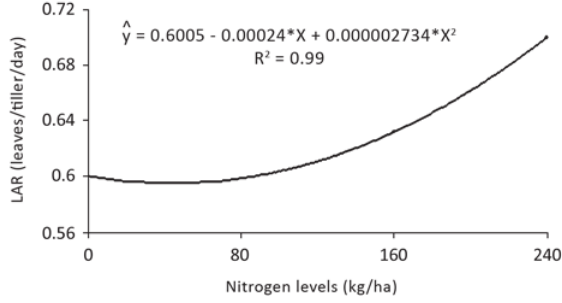
Figure 1 - Rate of the leaf appearance rate (LAR) of the B. brizantha cultivars in function of increasing nitrogen levels. (*P < 0.05).